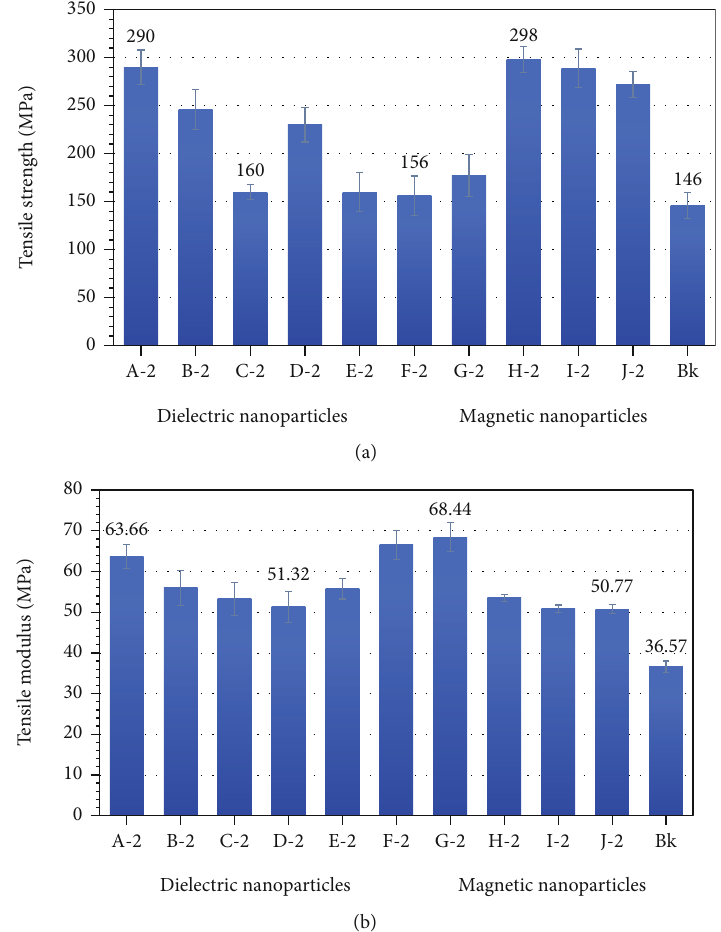
Figure 10: E ff ect of magnetic and dielectric nano fi llers on (a) tensile strength and (b) Young ’ s modulus (A: MWCNTs, B: SiC, C: Gp, D: CB, E: MnO , F: TiO , G: CoO, H: NiO, I: ZiO, J: Fe 2 2